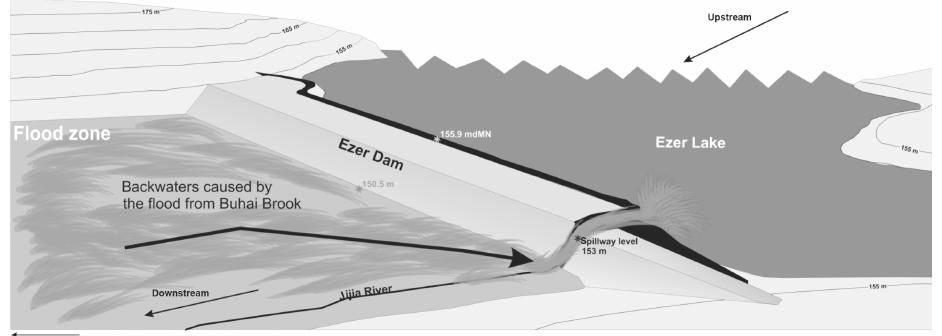
Figure 13. The “spider flow” phenomenon in which the Buhai waters climbed the Ezer dam on the Jijia, in the area of confluence of the two rivers.